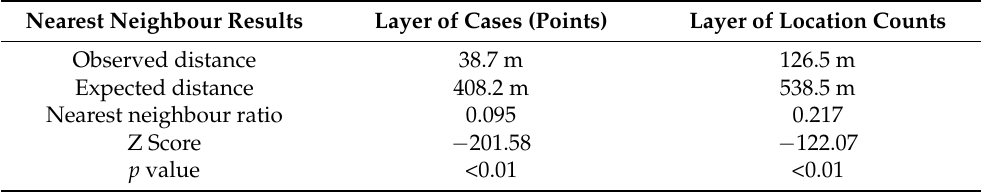
Table 2. The spatial average nearest neighbour: COVID-19 cases and COVID-19 location counts (num- ber of COVID-19 cases overlapped in the same points because of same address: street and number). Nearest Neighbour Results Layer of Cases (Points) Layer of Location Counts Observed distance 38.7 m 126.5 m Expected distance 408.2 m 538.5 m Nearest neighbour ratio 0.095 0.217 Z Score − 201.58 − 122.07 p value